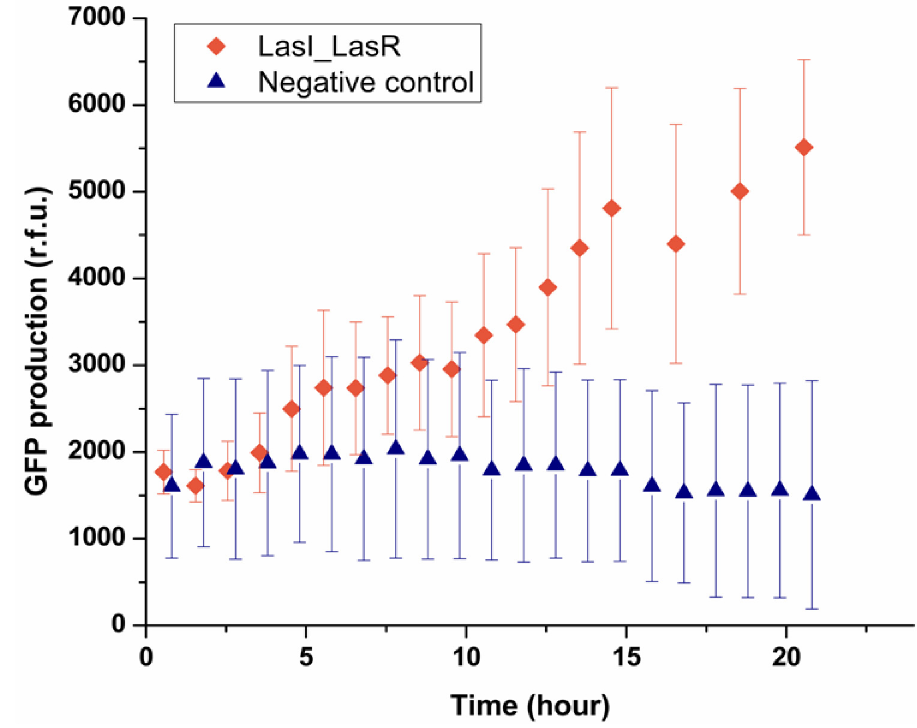
Figure 5. LasR-dependent GFP production triggered by diffusion of OdDHL secreted by LasI-expressing E. coli encapsulated in the droplet contacting the droplet containing LasR-expressing E. coli . In the negative experiment, no LasI-expressing E. coli was encapsulated in the trapped droplet. Each data point was averaged by measuring hundreds of single